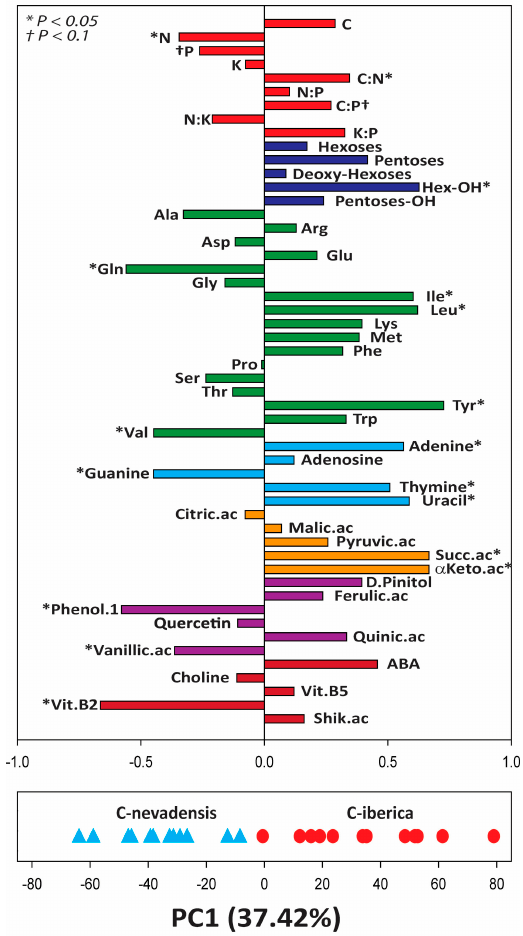
Figure 1. Variable and case plot of the principal component (PC) 1 of the principal component analysis (PCA) including all elemental, stoichiometric, and metabolomic data of the dataset of caterpillars (Caterpillar-Dataset). Only elemental, stoichiometric, and identified metabolomic variables are shown in the variable plot. Each bar represents the loading value for each variable on PC1. Elemental and stoichiometric variables are shown in red. Metabolite groups are shown in different colors: dark blue, saccharides (carbohydrates); green, amino acids; light blue, nucleobases/nucleosides; orange, organic acids related to tricarboxylic acid cycle; violet, phenolic compounds; and dark red, other. Caterpillars feeding on Pinus sylvestris ssp. iberica (C-iberica) are shown in blue triangles and caterpillars feeding on Pinus sylvestris ssp. nevadensis (C-nevadensis) are shown in red circles. Asterisks and crosses next to elemental, stoichiometric and metabolomic variables denote statistical significance (* p < 0.05) and marginal significance ( † p < 0.1),